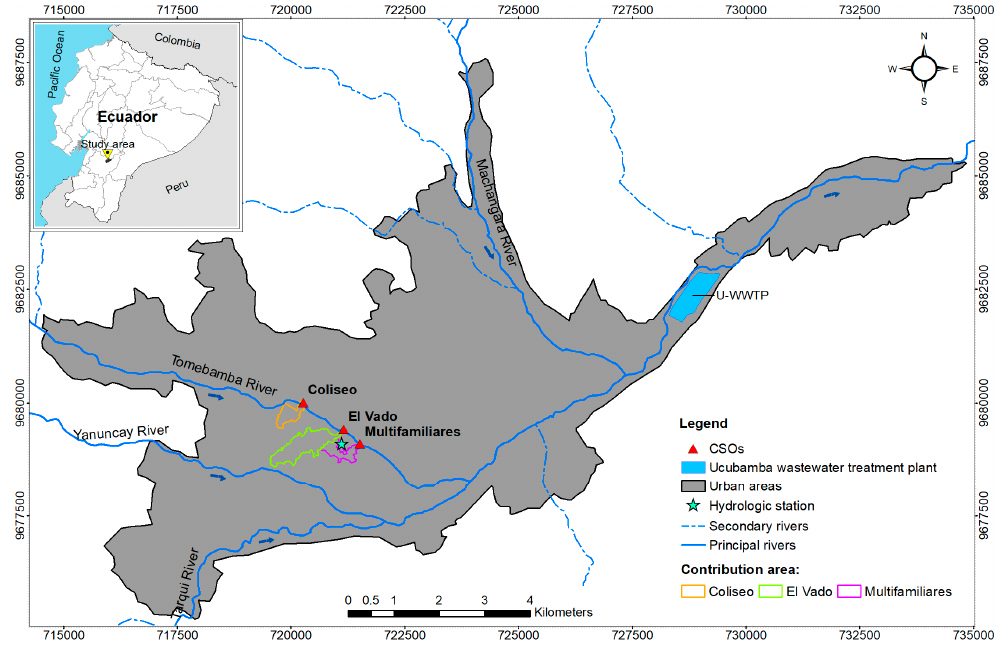
Figure 1. Map of the CSOs location, including the combined sewer overflow (CSO) contribution areas. Georeferenced UTM-WGS 84.